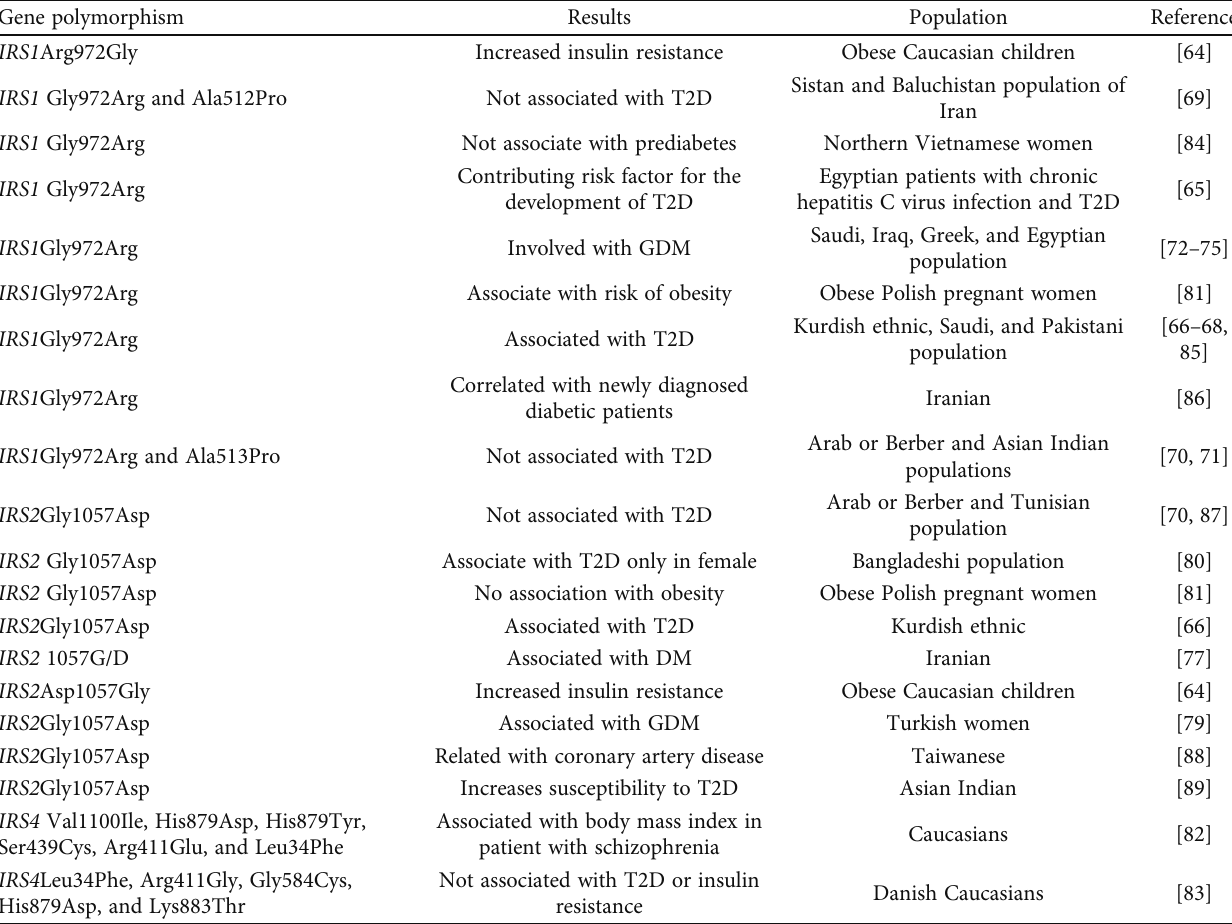
Table 3: Association with gene polymorphism of IRS with insulin resistance or DM in various